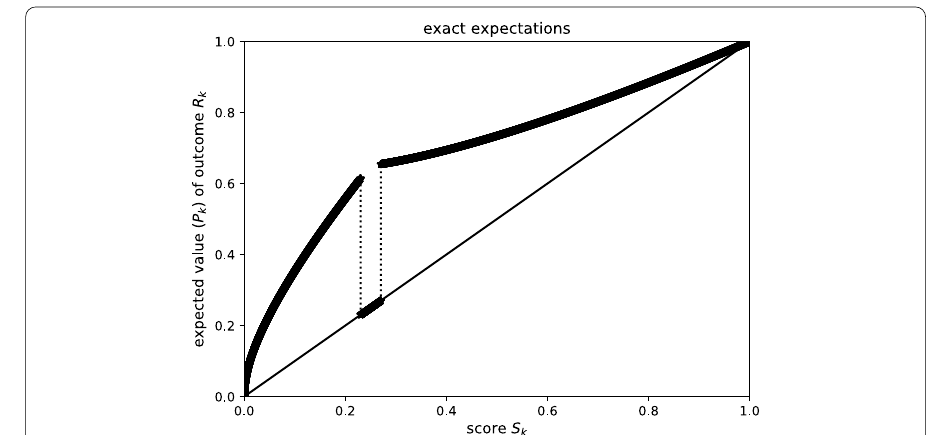
Fig. 35 Ground-truth reliability diagram for Fig. 34